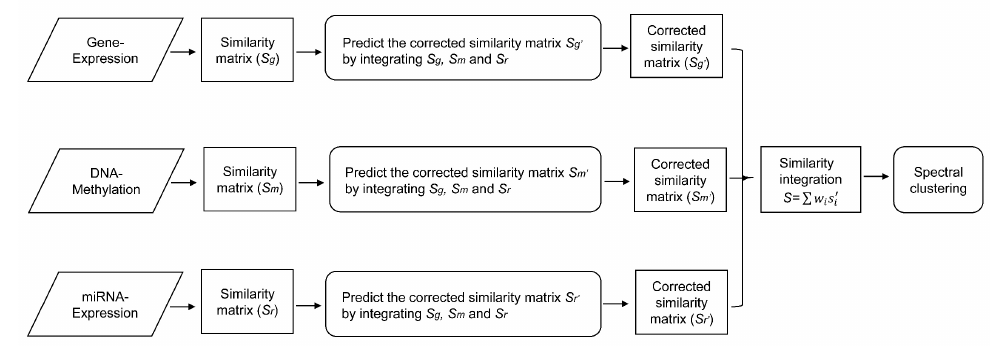
Figure 1. Illustration of the proposed similarity fusion approach. Suppose gene expression, DNA methylation, and miRNA expression data are integrated to identify cancer